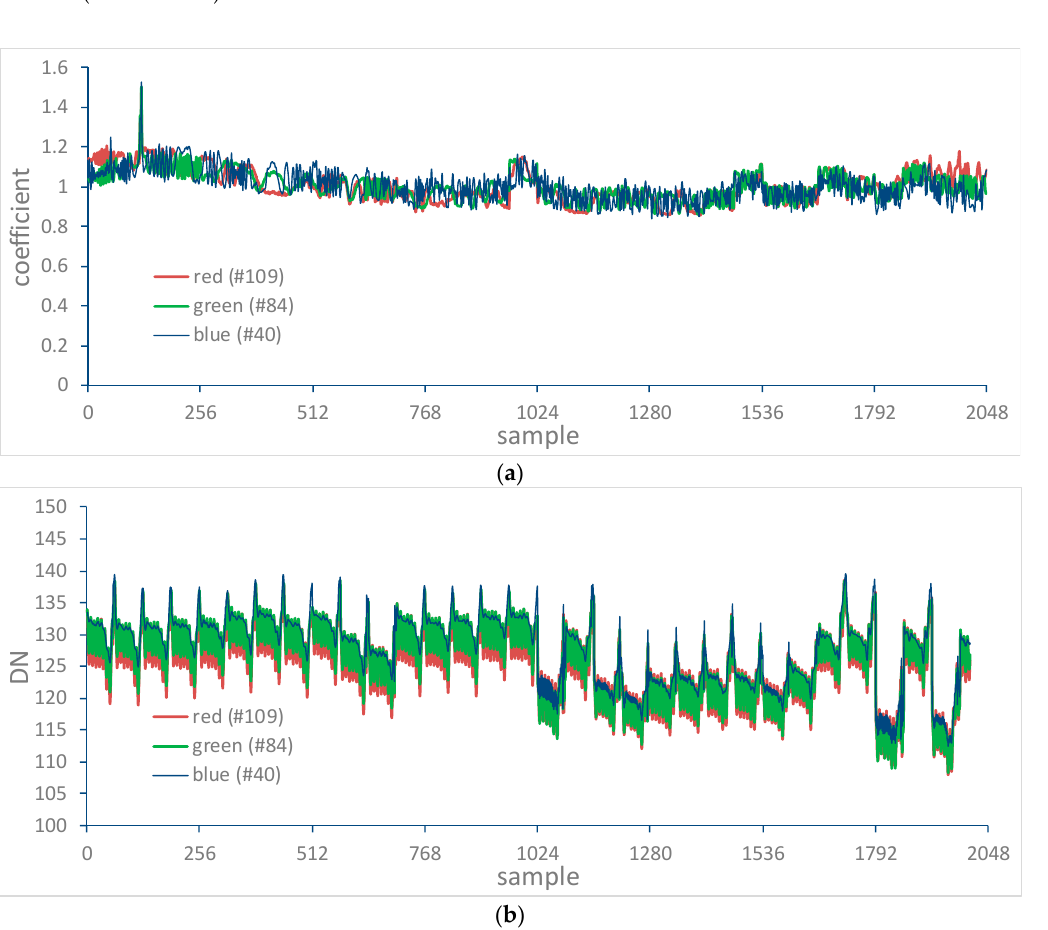
Figure 19. Relative radiometric correction coefficients for SPARK-02 satellite images at 638.0 nm, 549.5 nm, and 459.0 nm showing ( a ) gain curves (non-uniform correction coefficients) and ( b ) offset curves (dark current).